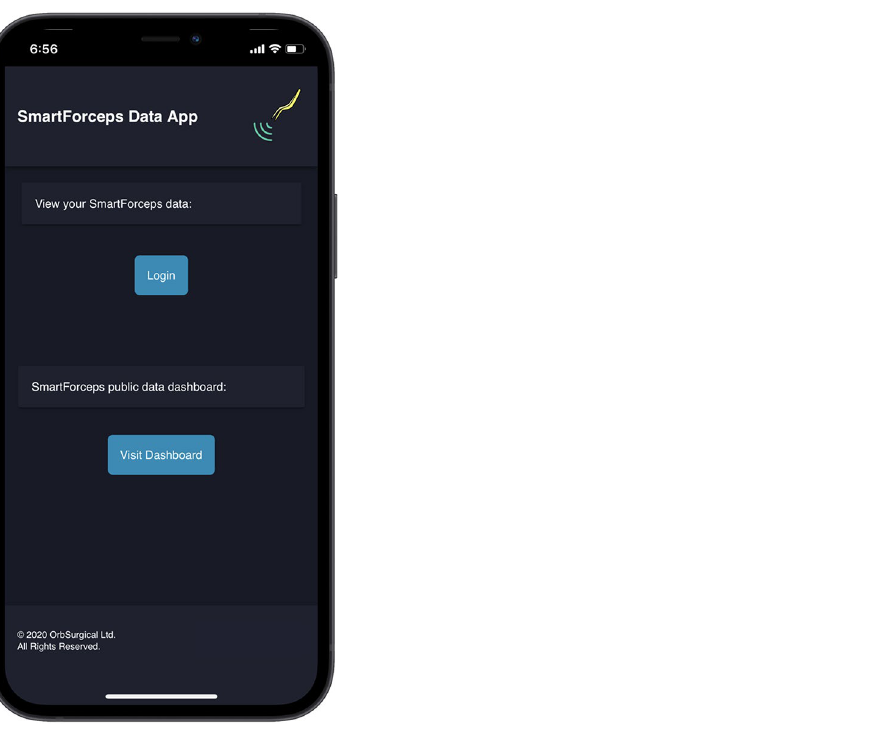
tion for SmartForceps cases across the world with multiple choice selection lists and interactive maps to display the information in a searchable table (Fig. 3a); (2) For both data scientist and surgeon: Surgical Force Data for visualizing different engineered features across each task through interactive distribution plots showing detailed statistics for Expert or Novice surgeons to compare and reproduce each force segment through mouse hover and click (Fig. 3b); (3) For surgeon: Performance Comparison Dashboard for tracking of individual perfor- mance over time characterized by task completion time, range of force application, force variability index, and force uncertainty index (level of entropy in time series data) compared to the average and range of an expert surgeon (Fig. 4); (4) For data scientist: Skill Prediction Tool that provides the necessary elements and gadgets for a step-by-step training and testing of support vector machine (SVM) models with parameter fine-tuning and generating results to distinguish surgical expertise (Fig. 5a); and (5) For data scientist: Task Recognition Tool for visualizing, training and testing of long short-term memory (LSTM) deep learning model with parameter fine- tuning and generating results to perform surgical task classification (Fig. 5b). Statistical data analytics. Data were analysed prior to dashboard visualization and data modelling exper- imentation for a better behaviour understanding of the force profiles. Summary statistics were extracted for each task and surgeon experience that included the number of force segments and mean (SD) of the force features across all available segments. The features used for statistical analysis are provided in Table 1. These hand-crafted features following inspections through statistical analysis will be used in-part or as an augmentation to the future machine learning models. The number of force segments were 2085 for Coagulation (Expert: 1108; Novice: 977), 303 for Pulling (Expert: 192; Novice: 111), 296 for Manipulation (Expert: 210; Novice: 86), 89 for Dissecting (Expert: 64; Novice: 25), and 122 for Retracting (Expert: 71; Novice: 51), with a total value of 1645 for Expert and 1250 for Novice surgeons. The mean (SD: Standard Deviation) for Force Duration in Coagulation was 12.1 (7.2) seconds—around 58% higher than the average of completion time in other tasks—while the completion time in Pulling, Manipula- tion, Dissecting, and Retracting tasks were 7.6 (5.3), 5.4 (2.5), 10.1 (8.6), and 7.6 (5.1) seconds, respectively. The mean (SD) for Force Range in Manipulation was 1.2 (0.5) N—around 52% higher than the average of completion time in other tasks—while the range of forces in Coagulation, Pulling, Dissecting, and Retracting tasks were 0.7 (0.5), 1 (0.6), 0.9 (0.5), and 0.7 (0.4) N, respectively. For presenting the level of force variability, Standard Devia- tion was calculated across the tasks and surgeons. The mean (SD) across all tasks were 0.23 (0.14) for Expert and 0.27 (0.14) for Novice surgeons. For materializing the unsafe force application risk, Force Peak Values were identified across the tasks and surgeons. The mean (SD) across all tasks were 0.35 (0.27) for Expert and 0.39 (0.29) for Novice surgeons. Level of Force Signal Entropy was used to measure the level of randomness in force